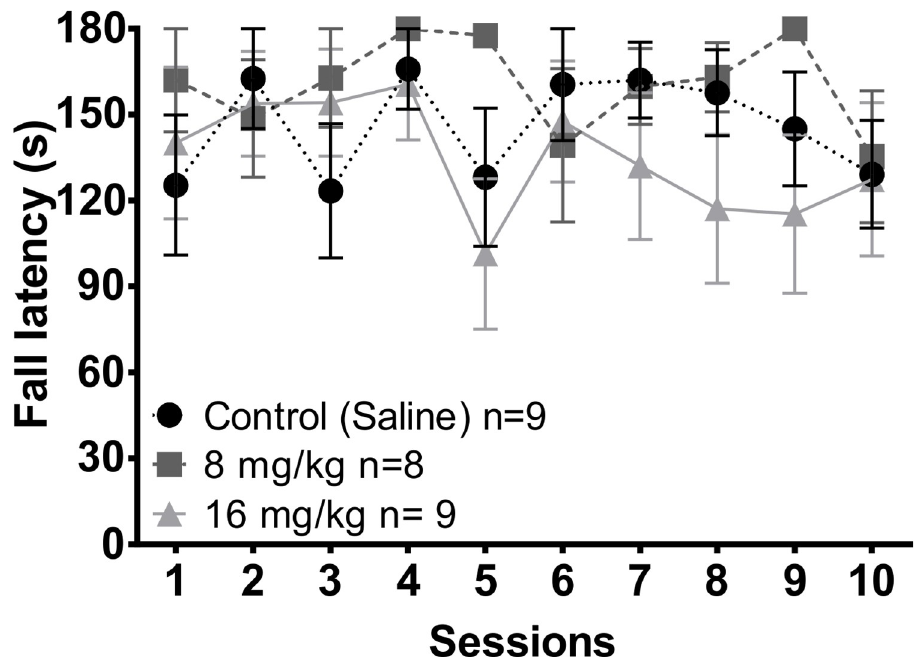
Fig 4. Fall latency in the constant velocity (10 rpm) rotarod test in the different groups of animals along the 10 weeks of testing. Twenty-four hours before sessions 1, 5 and 10 subjects were injected with saline, 8 mg/kg or 16 mg/ kg of MnCl 2 . Data are presented as mean +- SEM.